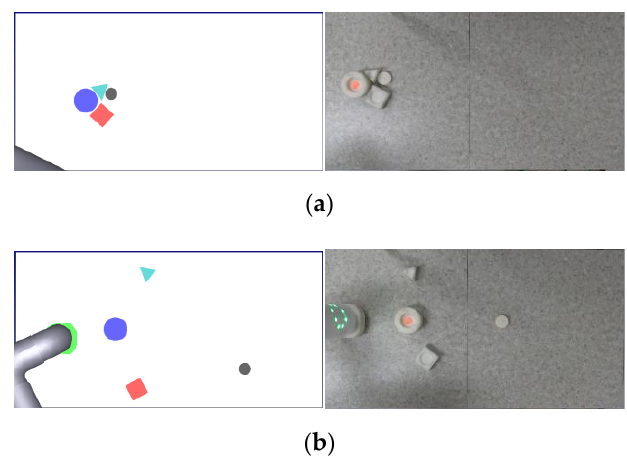
Figure 16. Scattering experiments for singulation of four objects by considering general shapes: ( a ) before collision; ( b ) after collision. Manipulator velocity: 0.5 m/s.